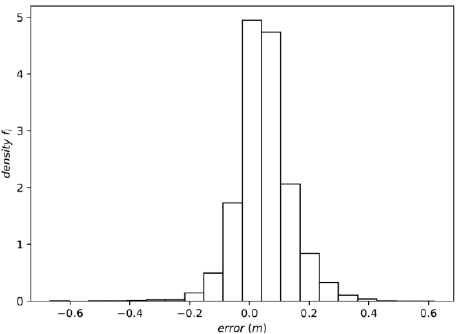
Figure 12. Histogram of the simulation absolute error.